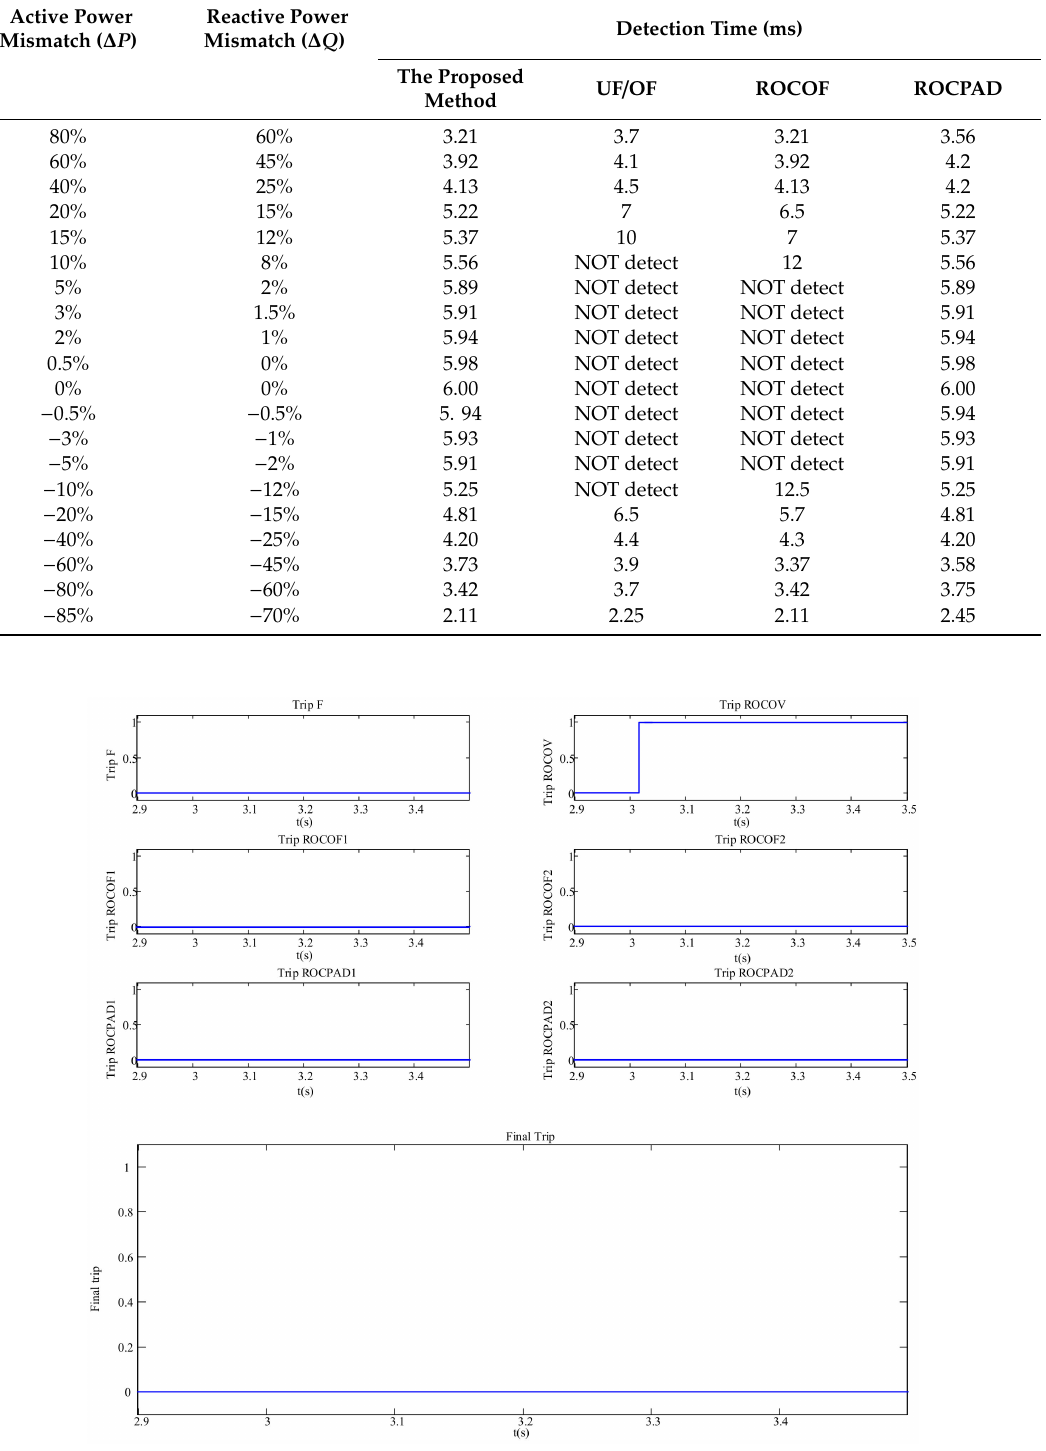
Figure 19. Trip signal of relays and the proposed algorithm in motor